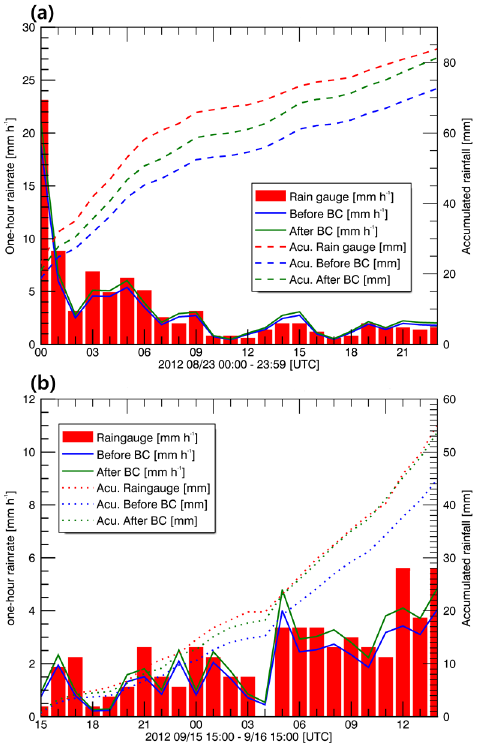
Figure 11. Comparison of the 1h rain rate (left ordinate) and accu- mulated rainfall (right ordinate) obtained by the BSL S-band radar and rain gauge. The R(Z H , Z DR ) algorithm based on Eq. (4) was used for rainfall estimations for (a) 23 August 2012 and (b) 16 September 2012. BC represents the bias